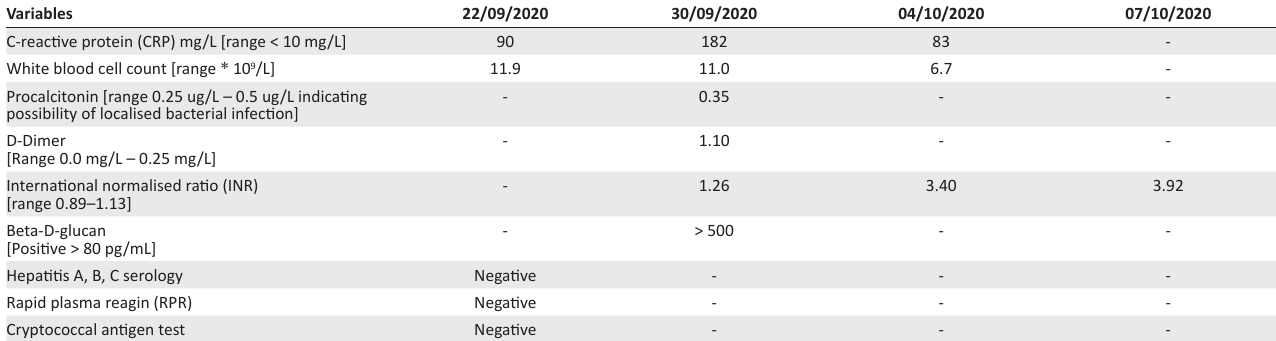
TABLE 1: Results of laboratory investigations. Variables